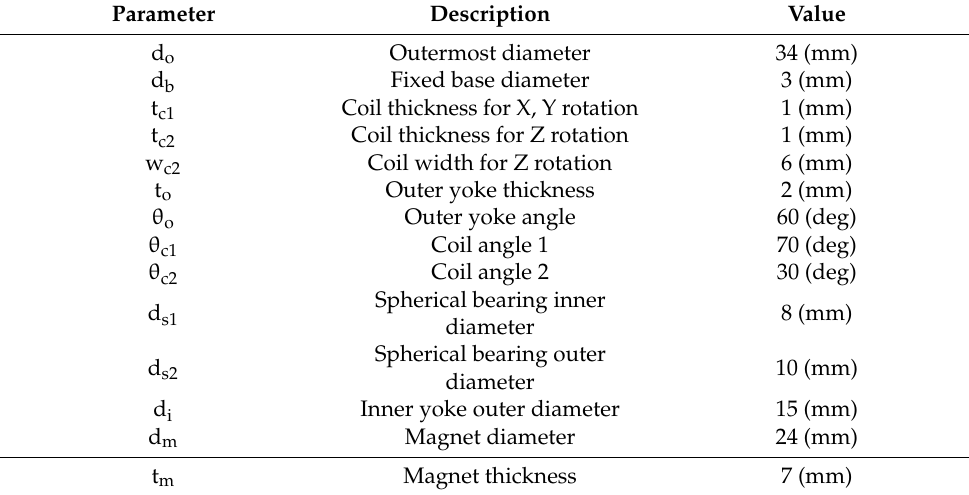
Figure 2. The design parameters of ( a ) the structure and ( b ) the rotor in Y -Z cross section in the proposed 3-DOF spherical VCM. Table 1. The dimensions of the design